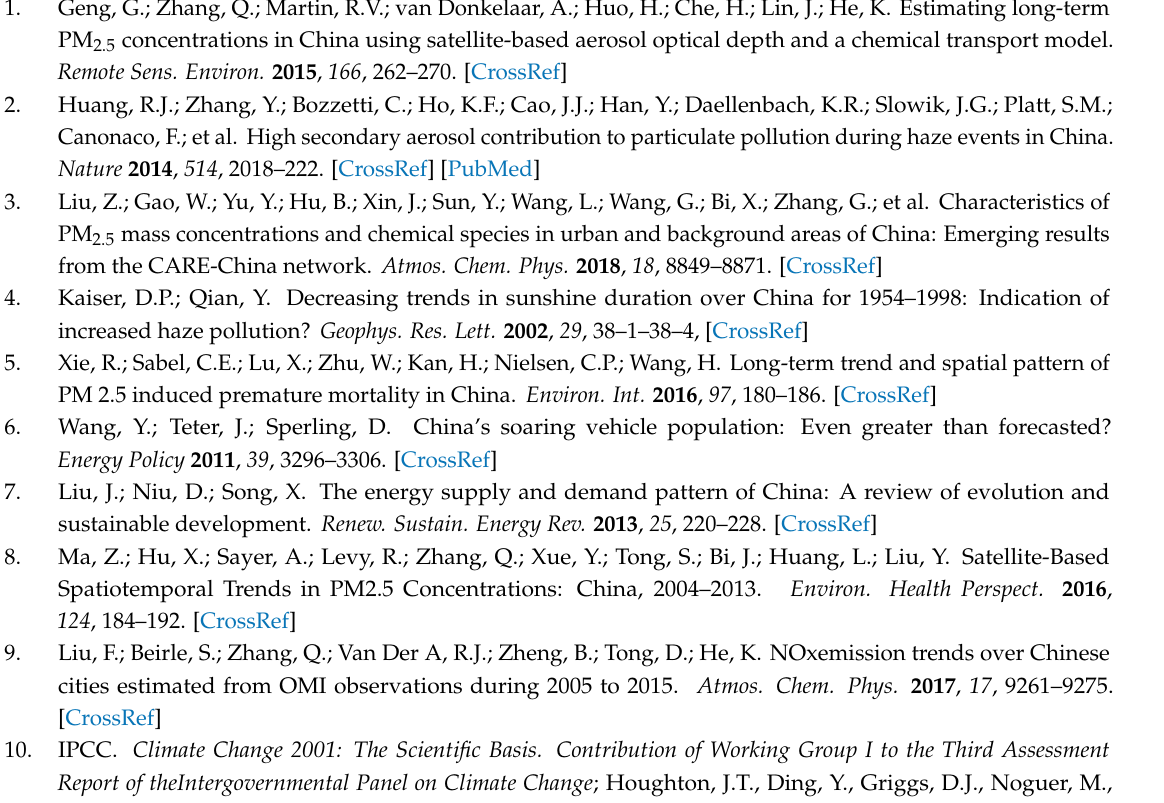
Figure S1: 550nm AOD spatial distribution to 1 ◦ × 1 ◦ resolution for 2011, 2013 and 2015. Table S1: Spatial correspondences between MODIS 550nm AOD and CHIMERE 550nm AOD. Table S2: CHIMERE Model PM 10 annual composition for Bejing, Chengdu and Shanghai. Figure S2: Daily PM 2.5 time series for monitoring stations and CHIMERE simulations. Figure S3: Daily Ångström coefficient distribution at Beijing station. Figure S4: PM 10 simulated surface concentration. Figure S5: PM station